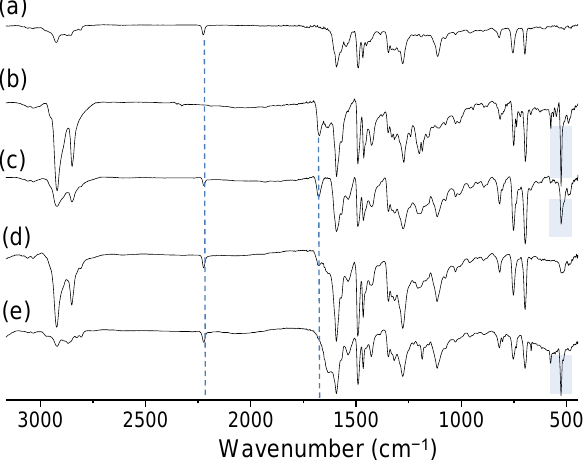
8 , ( b ) C (>DPAF-C ) 1 , ( c ) BrCPAF-C 18 60 18